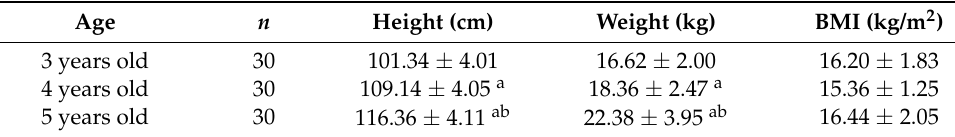
Table 1. Basic information about the participants (X ±